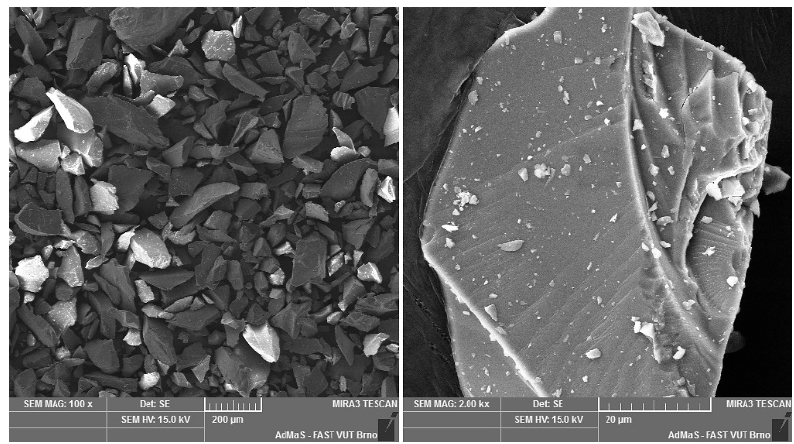
Figure A4. DS1 floated kaolin.